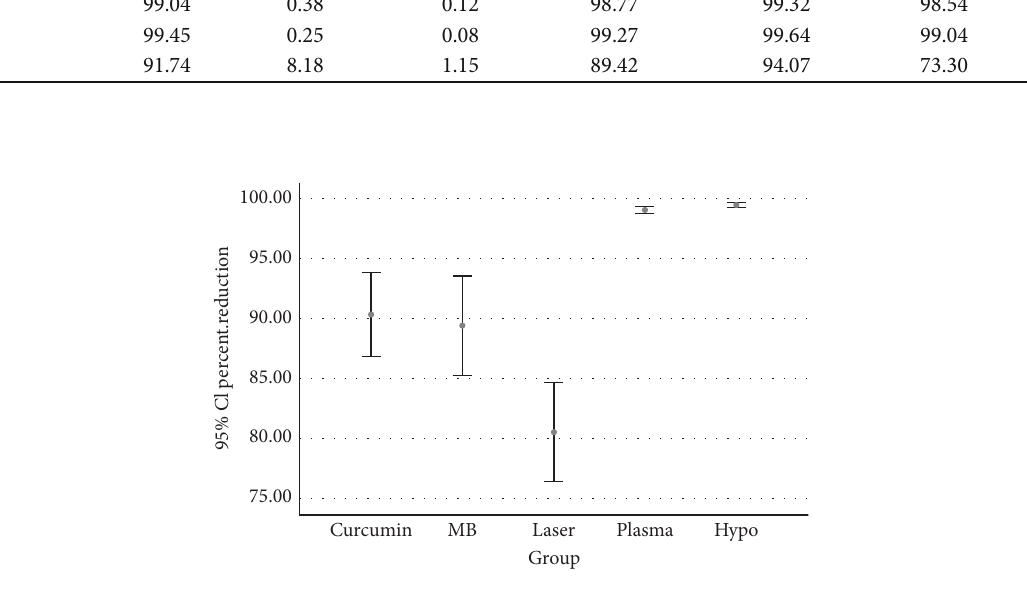
F IGURE 4: Percentage of reduction of colony count in the study